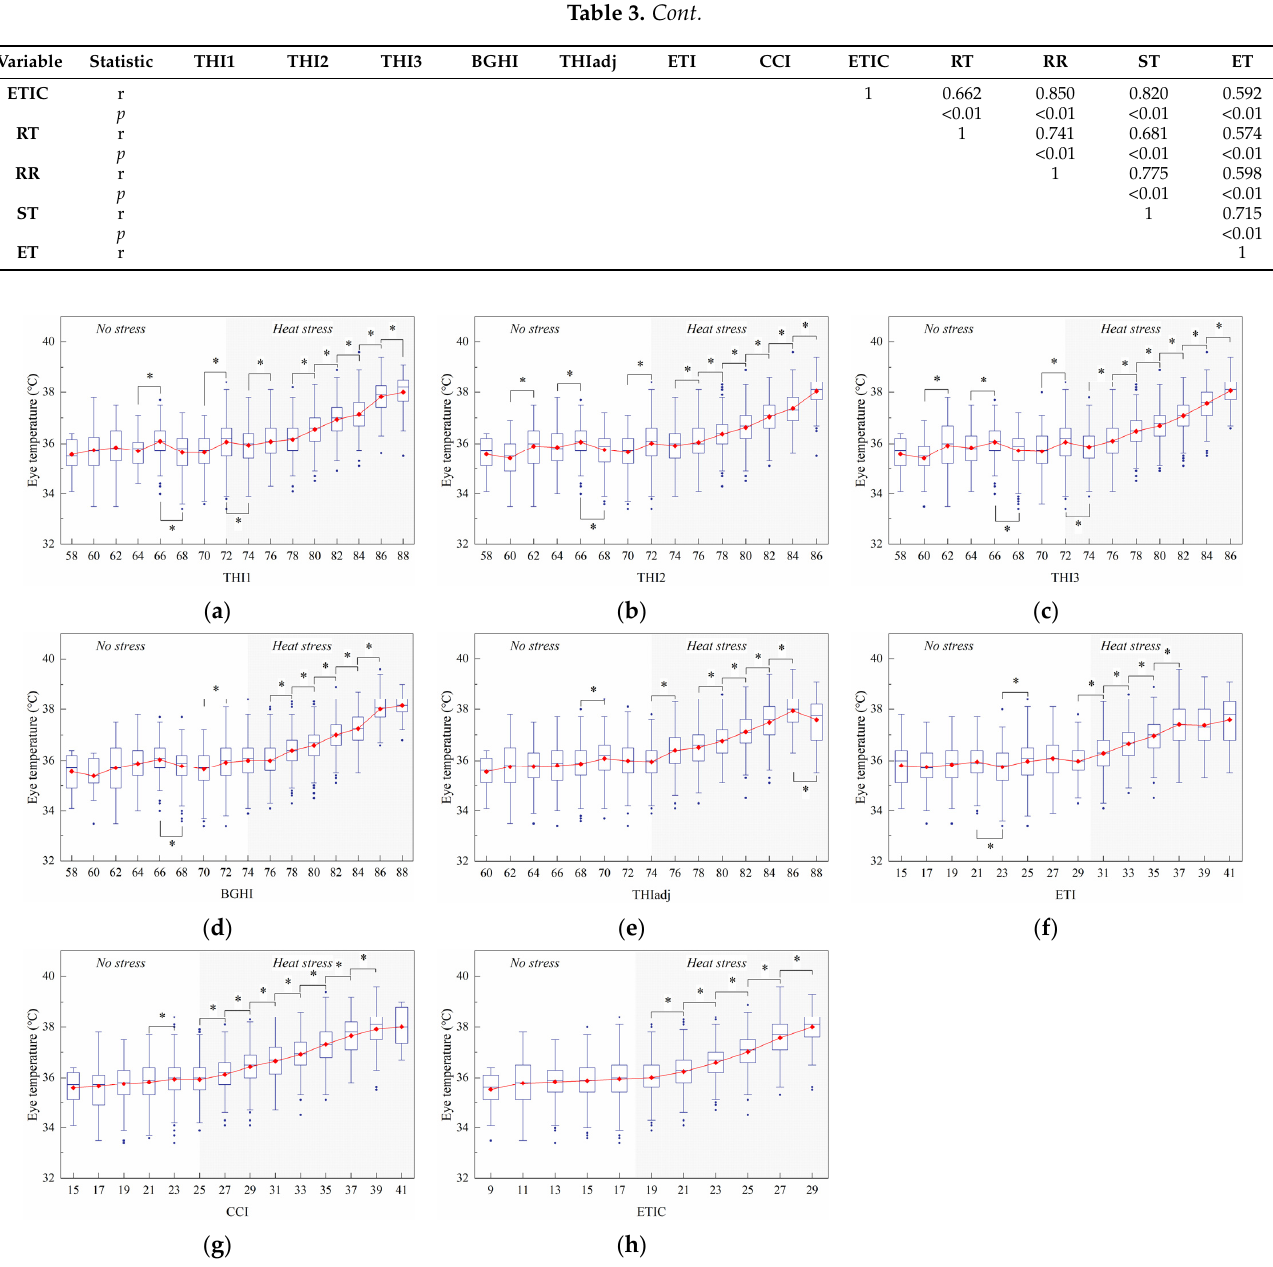
13 of 19 3.2.4. Eye Temperature